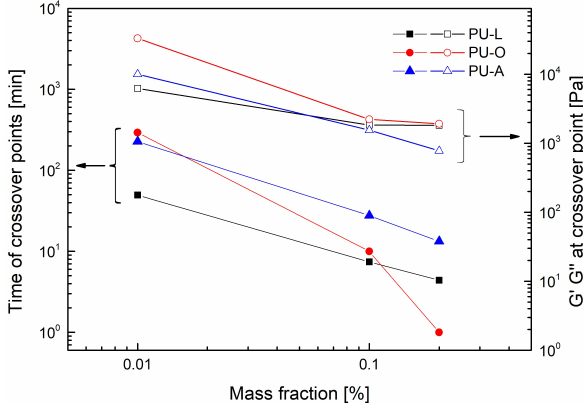
Figure 5: Time and value of G ′ and G ′′ at crossover point as a func- tion of mass fraction of each